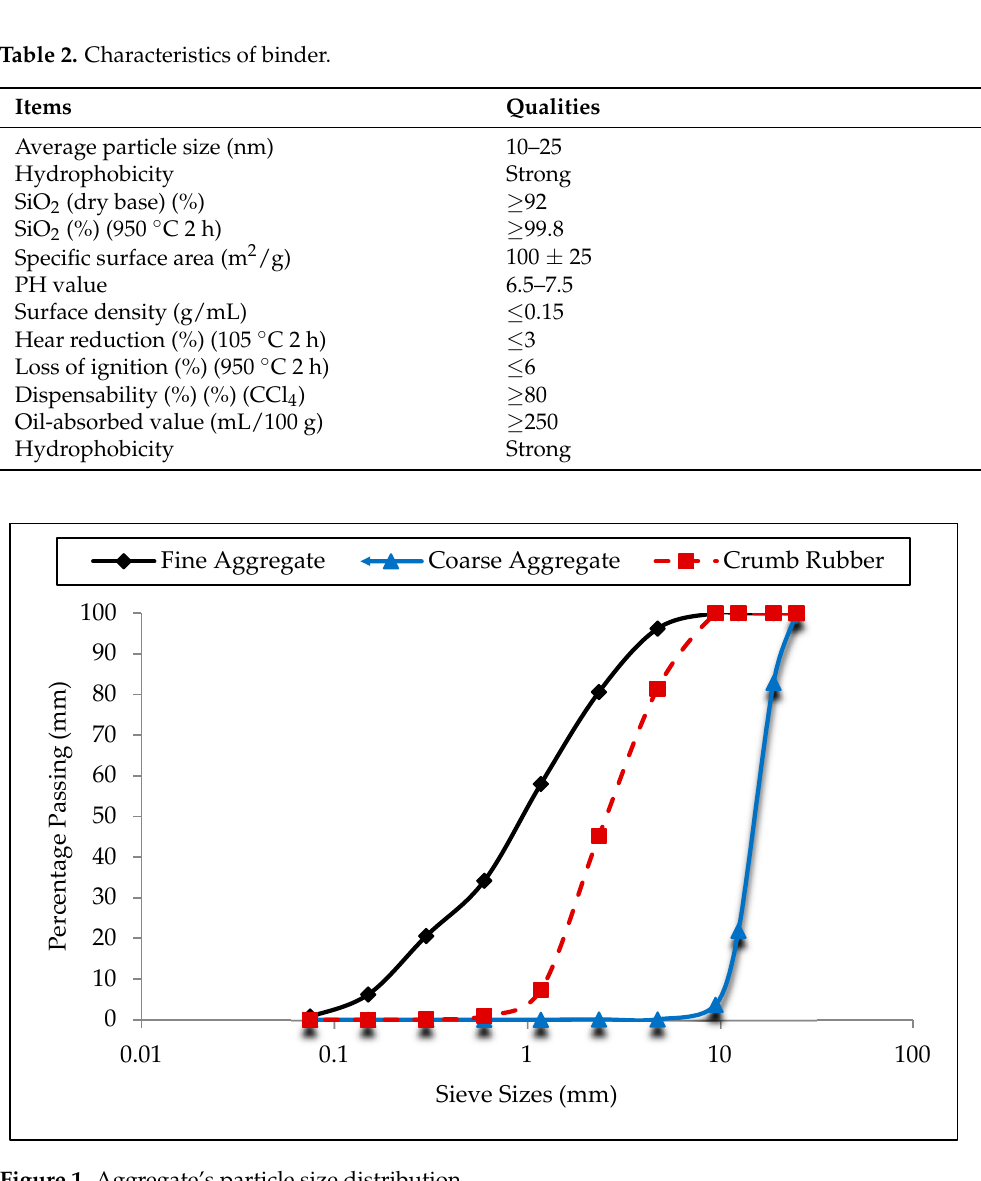
Figure 1. Aggregate’s particle size distribution.